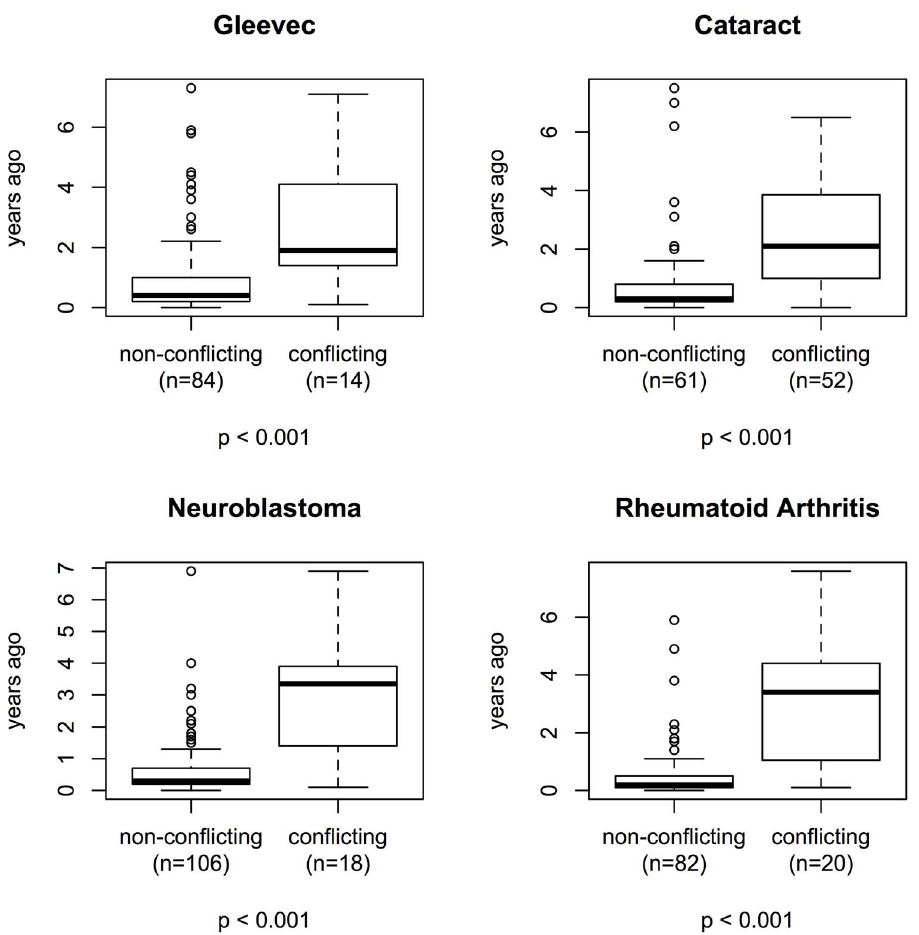
Figure 2. Comparison of the time since last update to whether the recruitment status is conflicting with the stated study completion date. Trials with a recruitment status conflicting with their stated completion date tended to not have been updated recently (p , 0.001). doi:10.1371/journal.pone.0111055.g002 PLOS ONE |